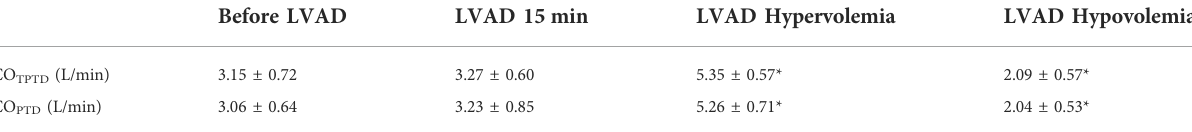
TABLE 1 Cardiac output over the study period.